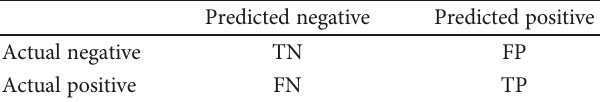
Table 4: Confusion matrix for the two-class problem.